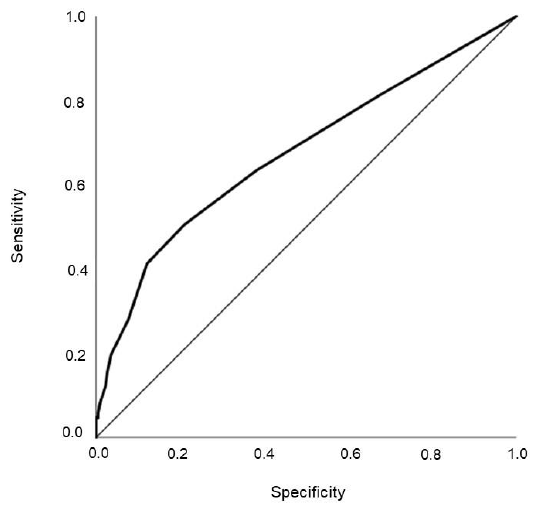
Figure 6. ROC curve analysis and prediction of hospitalization.